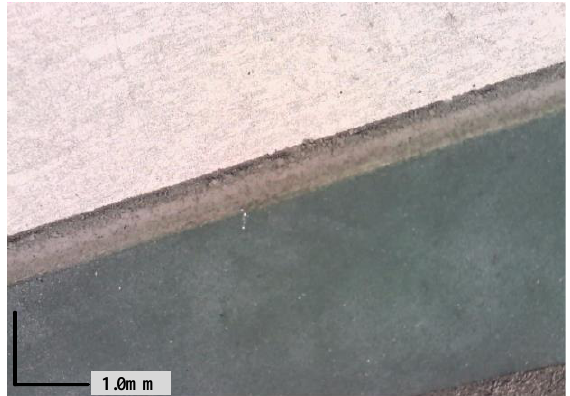
Figure 6. Laser grooving and removing chemical milling maskant of second scribing.